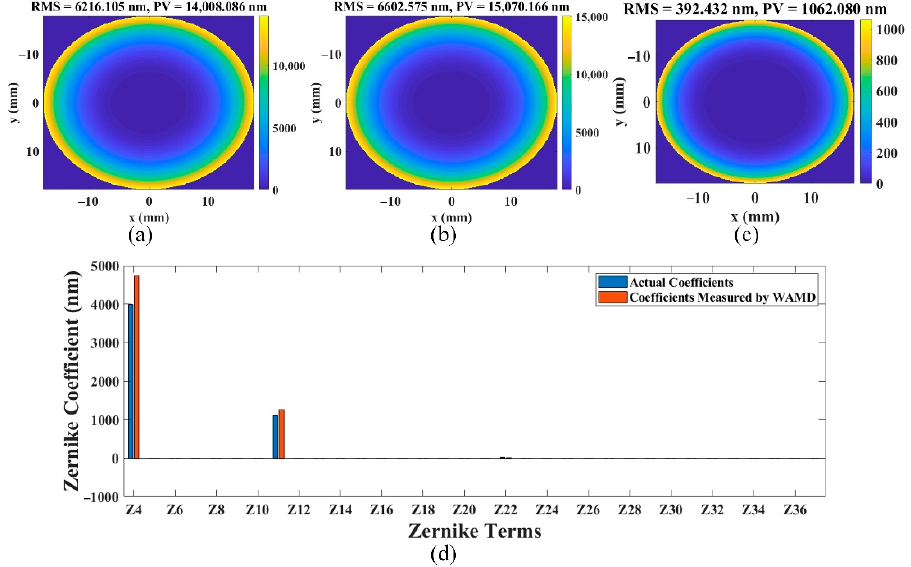
Figure 4. Wavefront aberration of the telephoto lens in the simulation: ( a ) actual wavefront aberra- tion; ( b ) wavefront aberration measured by WAMD; ( c ) difference between ( a , b ); ( d ) comparison of Zernike coefficients.